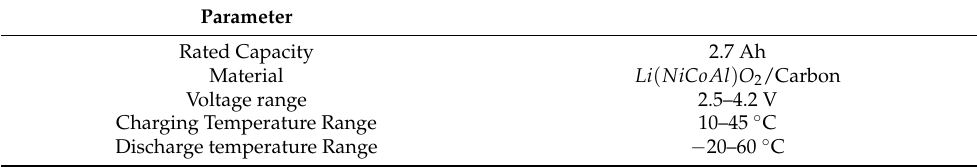
Table 1. 18650 battery information introduction.